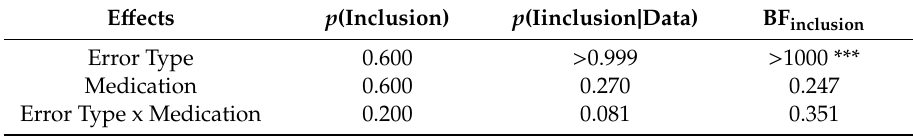
Table 2. Analysis of effects of error type and medication on conditional error probabilities.